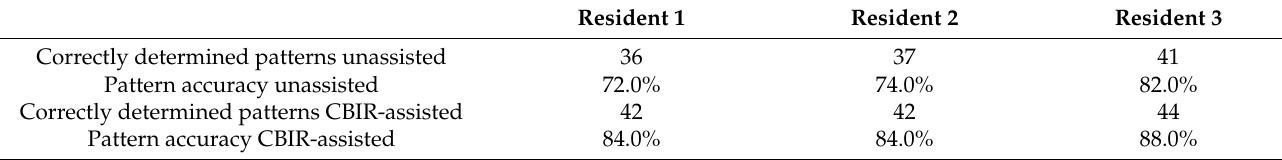
Table 6. Results of the radiology residents’ pattern accuracy. All radiology residents’ pattern accuracy in the unassisted test runs proved to be not significantly different from the CBIR-assisted test runs ( p = 0.016, p = 0.031 and p = 0.19,